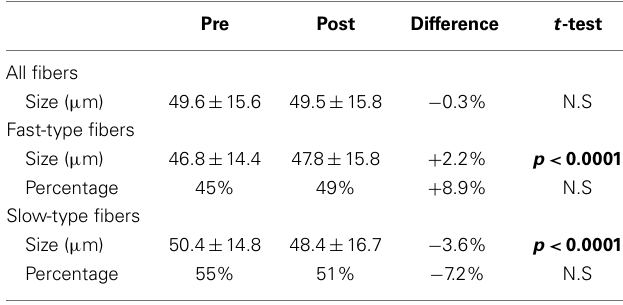
Table 2 | Mean myofiber diameter and fiber-type distribution in skeletal muscle biopsies pre- and post-training